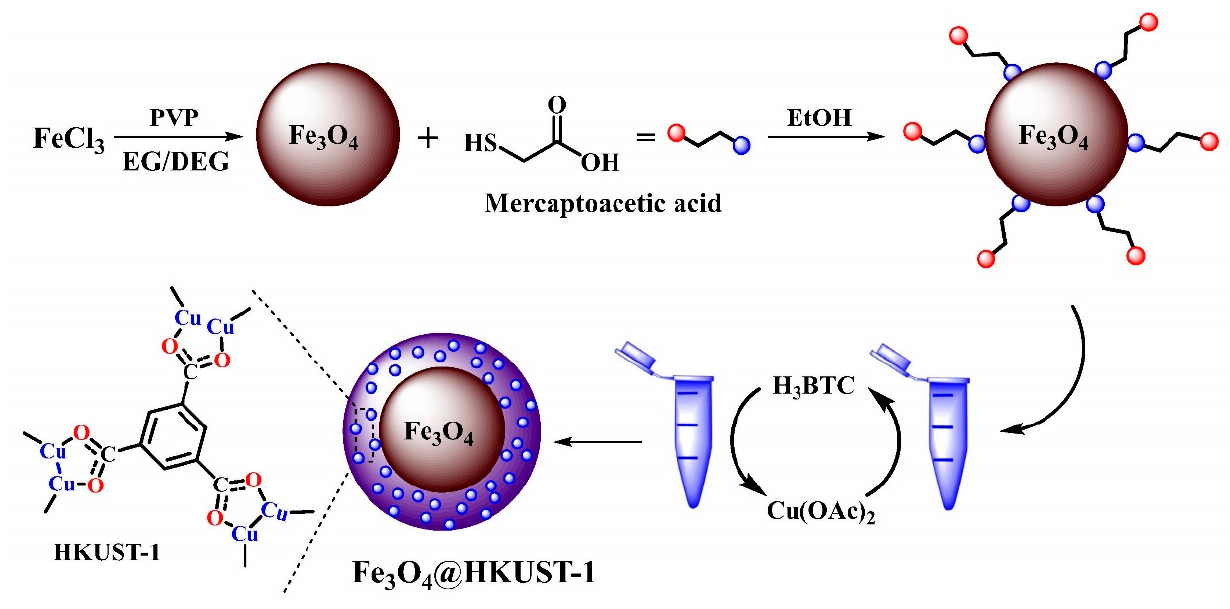
Figure 15. Synthesis of the catalyst Fe 3 O 4 @HKUST-1. [76].